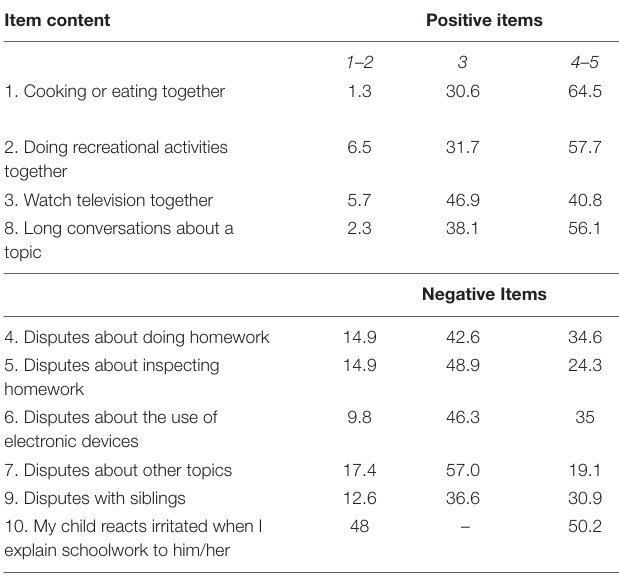
TABLE 3 | Itemized response percentages for the HHD scale, grouped by subscale. Item